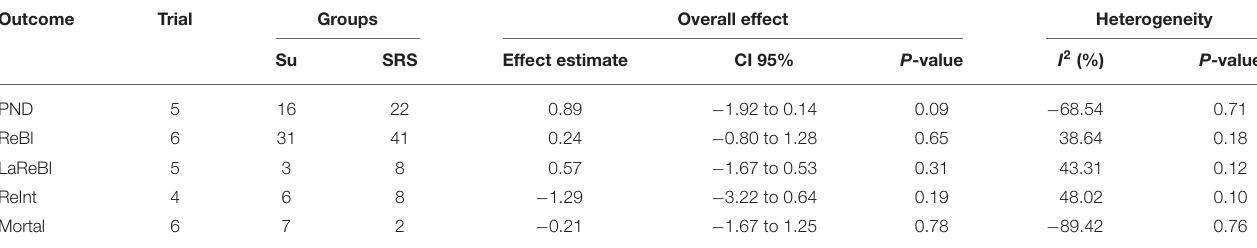
TABLE 2 | Meta-analysis results.